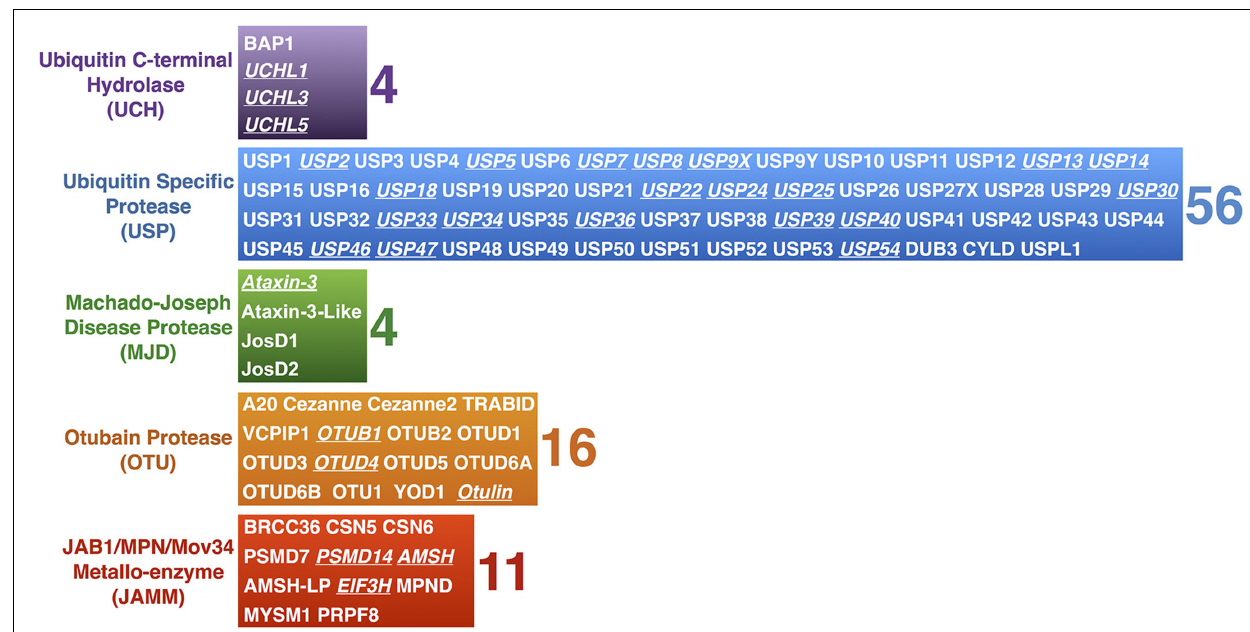
FIGURE 2 | Mammalian DUBs. Mammalian DUBs categorized by similarities at the protease domain. Highlighted are DUBs involved in the nervous system. With the exception of JAMM proteases, which are zinc-dependent metallo-proteases, the rest are cysteine proteases.